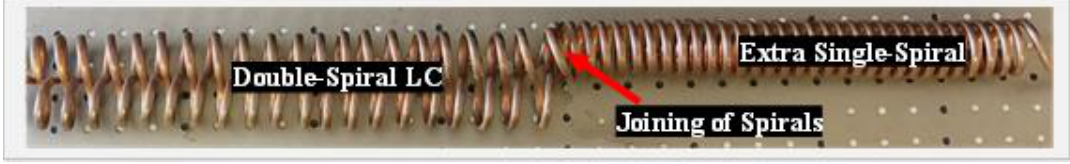
Figure 2. Test mockup of a double-spiral LC with an extra working spiral having a different inclination angle.